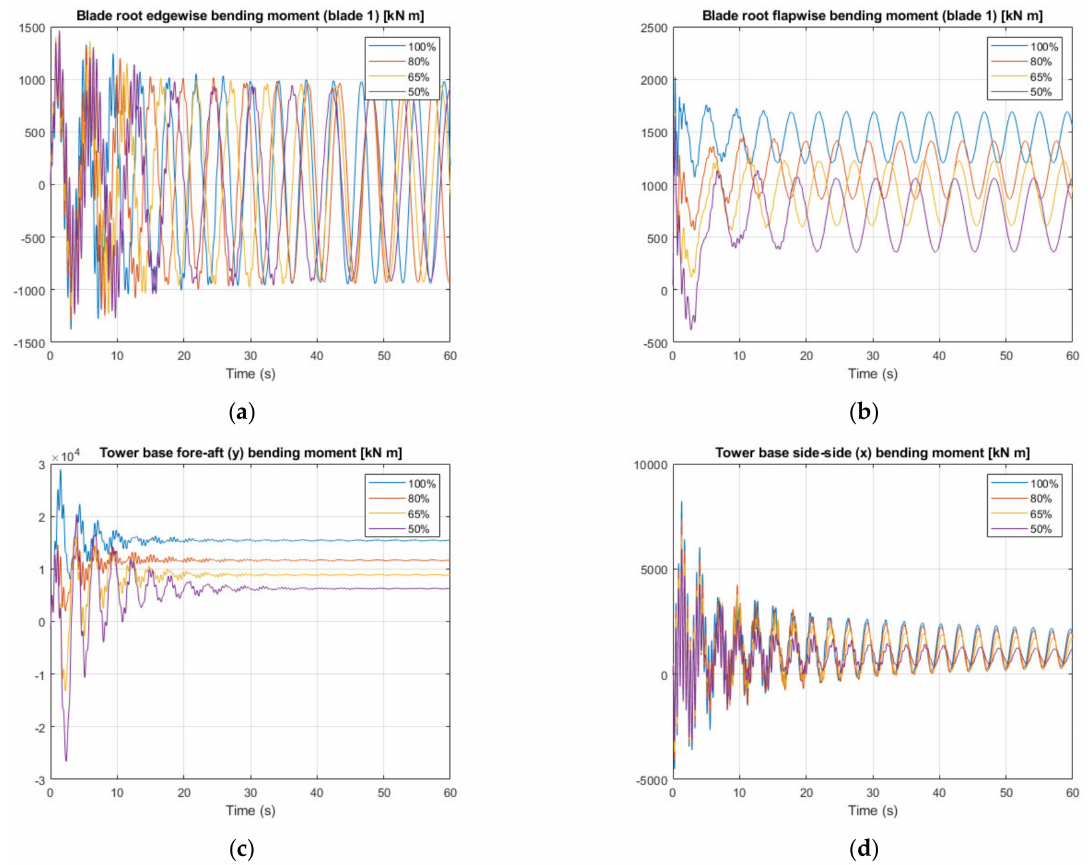
Figure 12. Simulation efforts at a different power limitations: ( a ) blade root edgewise moment; ( b ) blade root flapwise bending moment; ( c ) tower base fore–aft bending moment, ( d ) tower base side–side bending